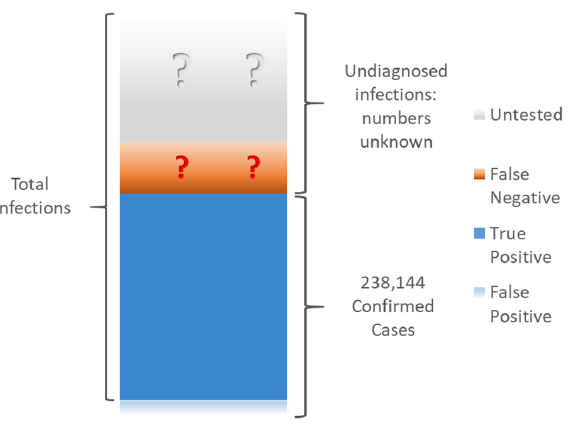
Figure 1. Total confirmed COVID-19 cases in Republic of Ireland as of 6 April 2021.